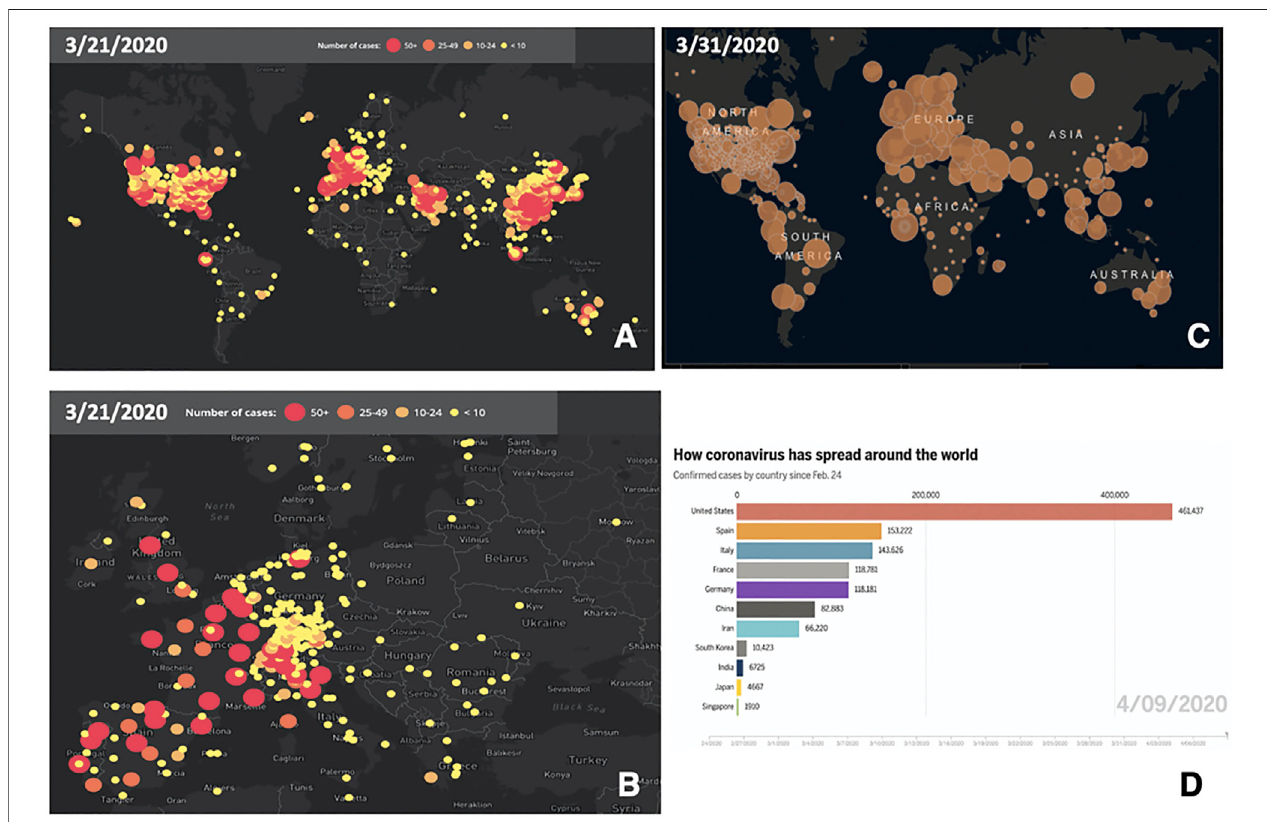
FIGURE 1 | Worldwide progression of COVID-19 cases. (A) COVID-19 cumulative case incidence across the world, as of March 21, 2020; numbers are color- coded and are proportional to circle diameter (www.healthmap.org/covid-19/). (B) COVID-19 cumulative case incidence, as in ( A ), zoomed over Central Europe.